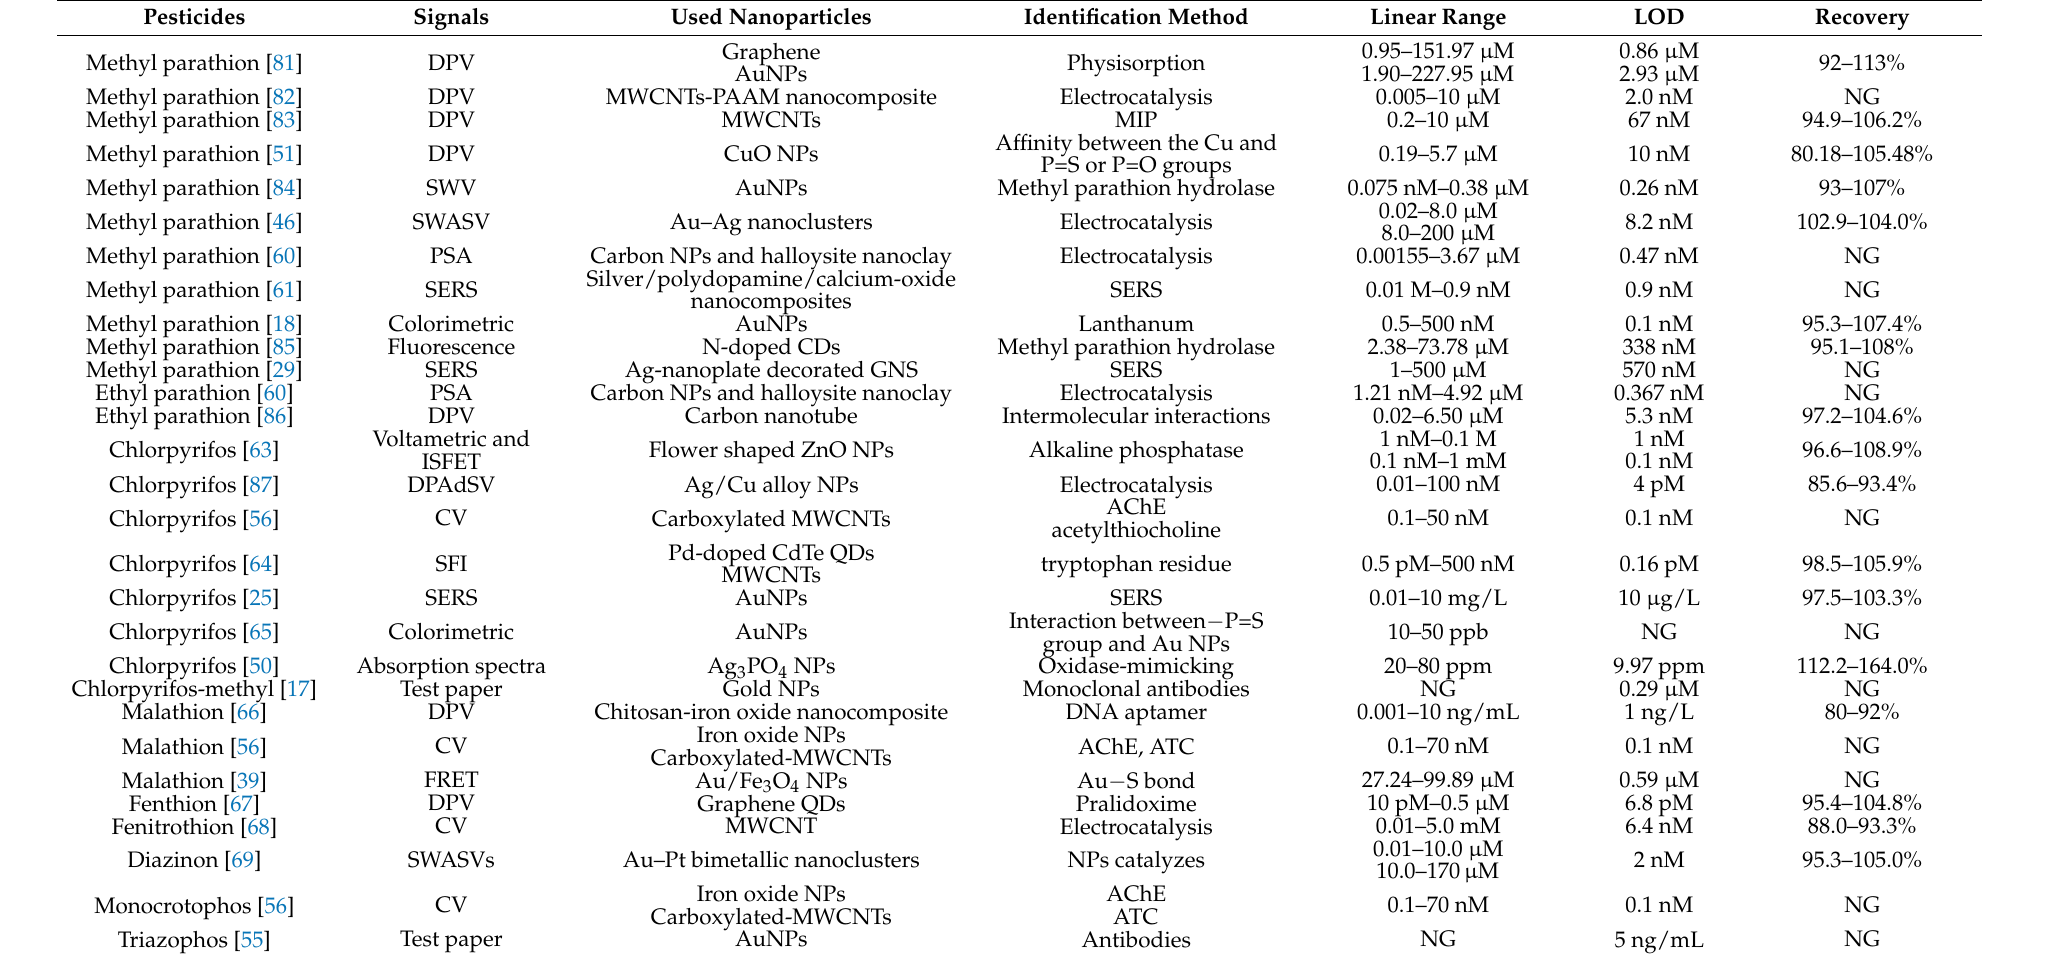
Table 1. The methods and their performances for the detection of